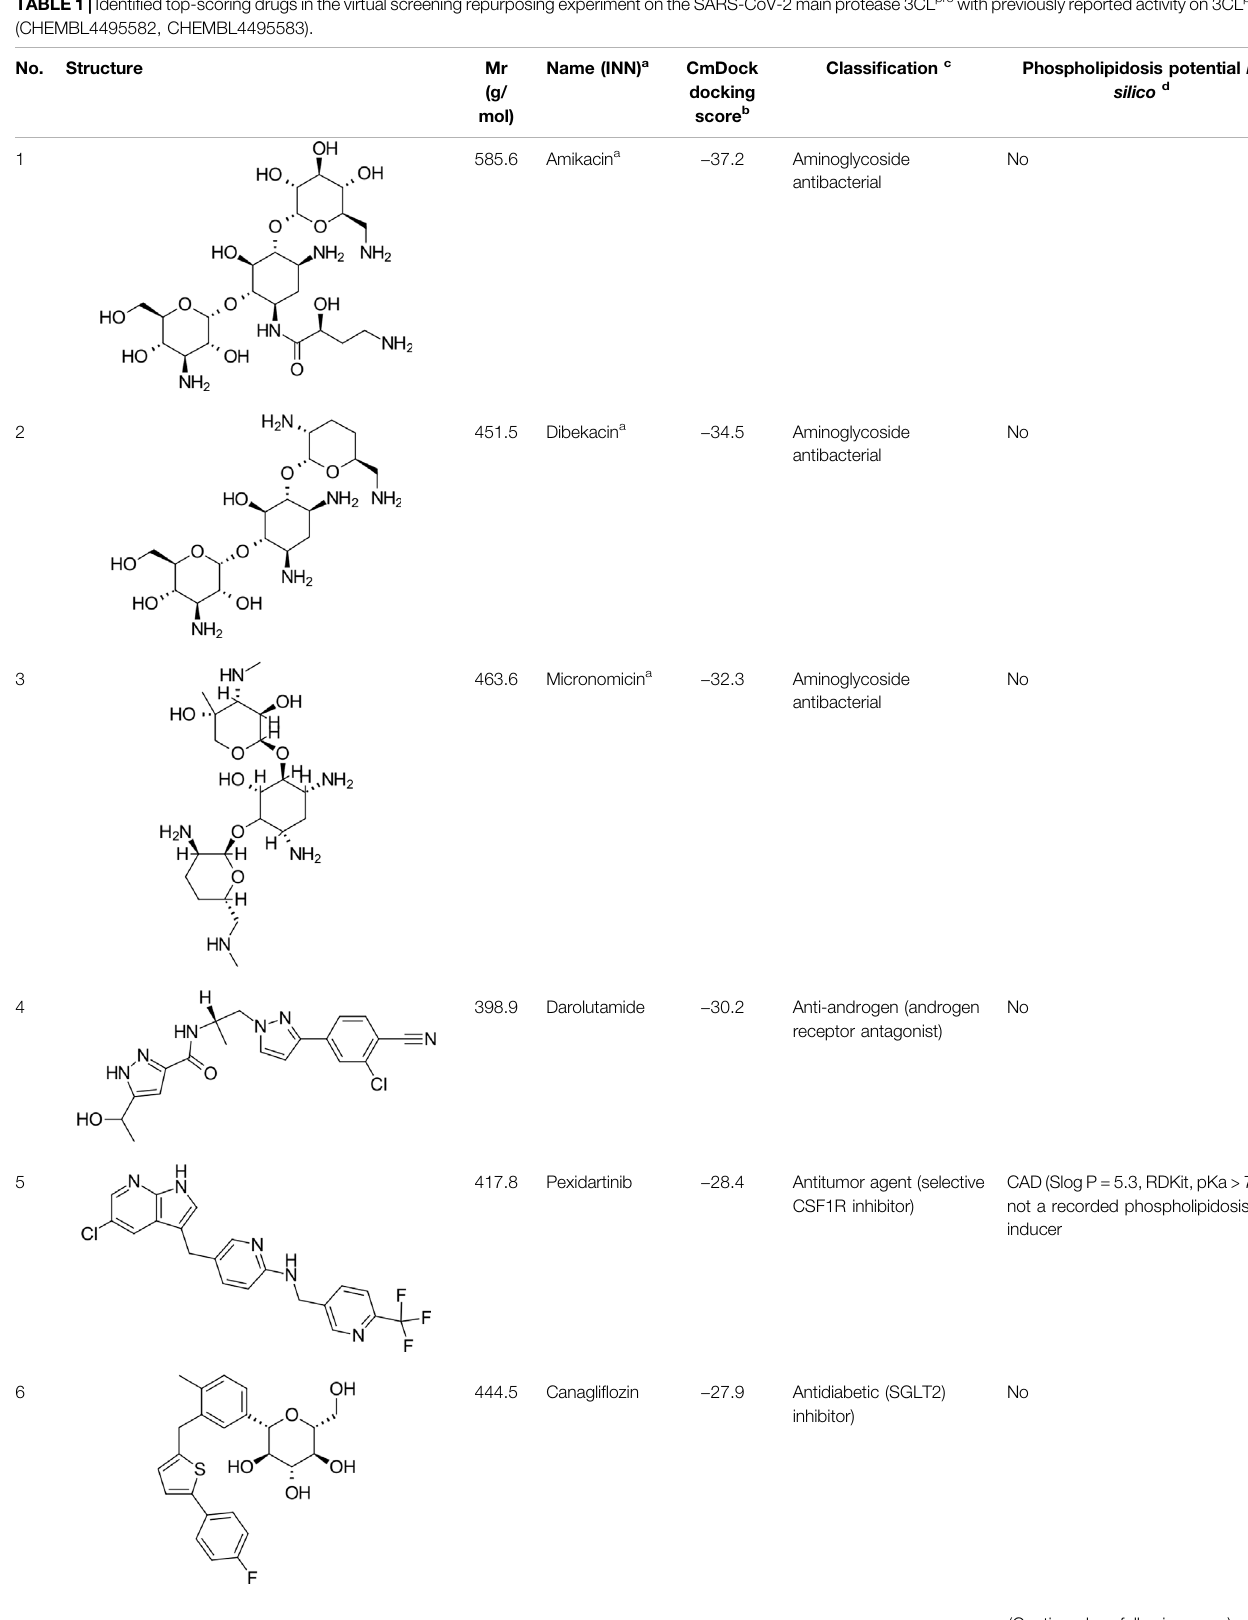
TABLE1| Identi fi edtop-scoringdrugsinthevirtualscreeningrepurposingexperimentontheSARS-CoV-2mainprotease3CL pro withpreviouslyreportedactivityon3CL pro (CHEMBL4495582,